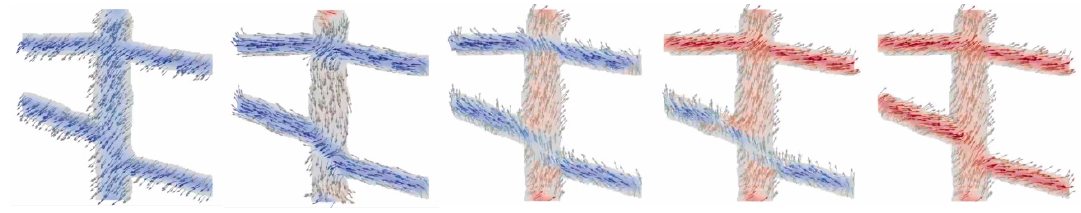
Figure 1. Magnetization reversal process in sample NF1 for an external magnetic field along 45° from “lower left” to “upper right” orientation. From Blachowicz et al. [29].